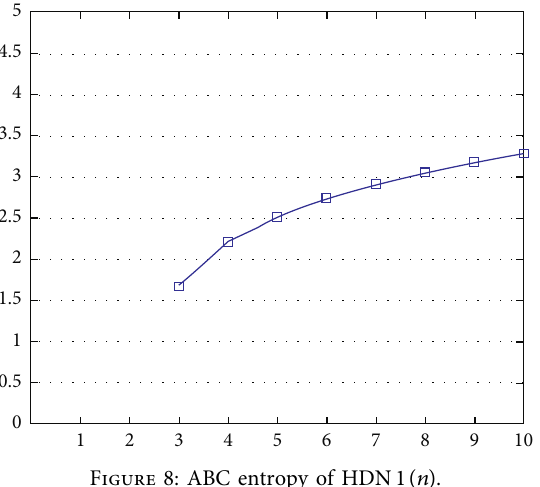
Figure 11: Randi´c entropy of HDN2 ( n ) for α � ( 1/2 )